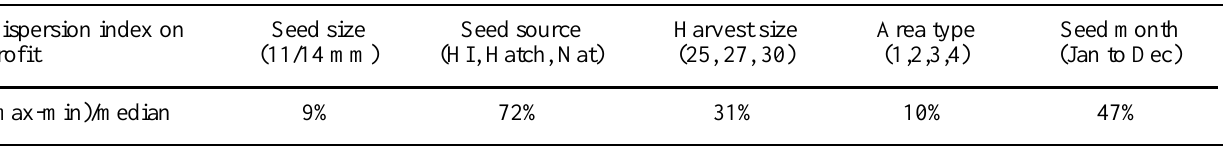
Table 6. Model sensitivity computed by measuring the dispersion index of the model scenario outputs (profits) and varying input parameters (seeding size and type, area type, harvesting size, seeding